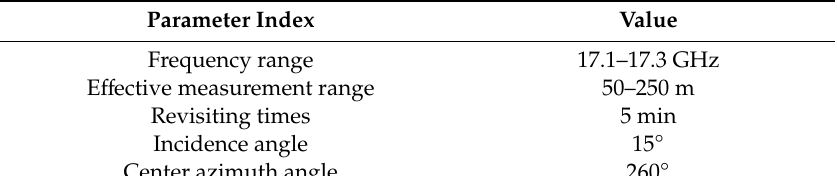
Table 1. GPRI-II equipment parameters.